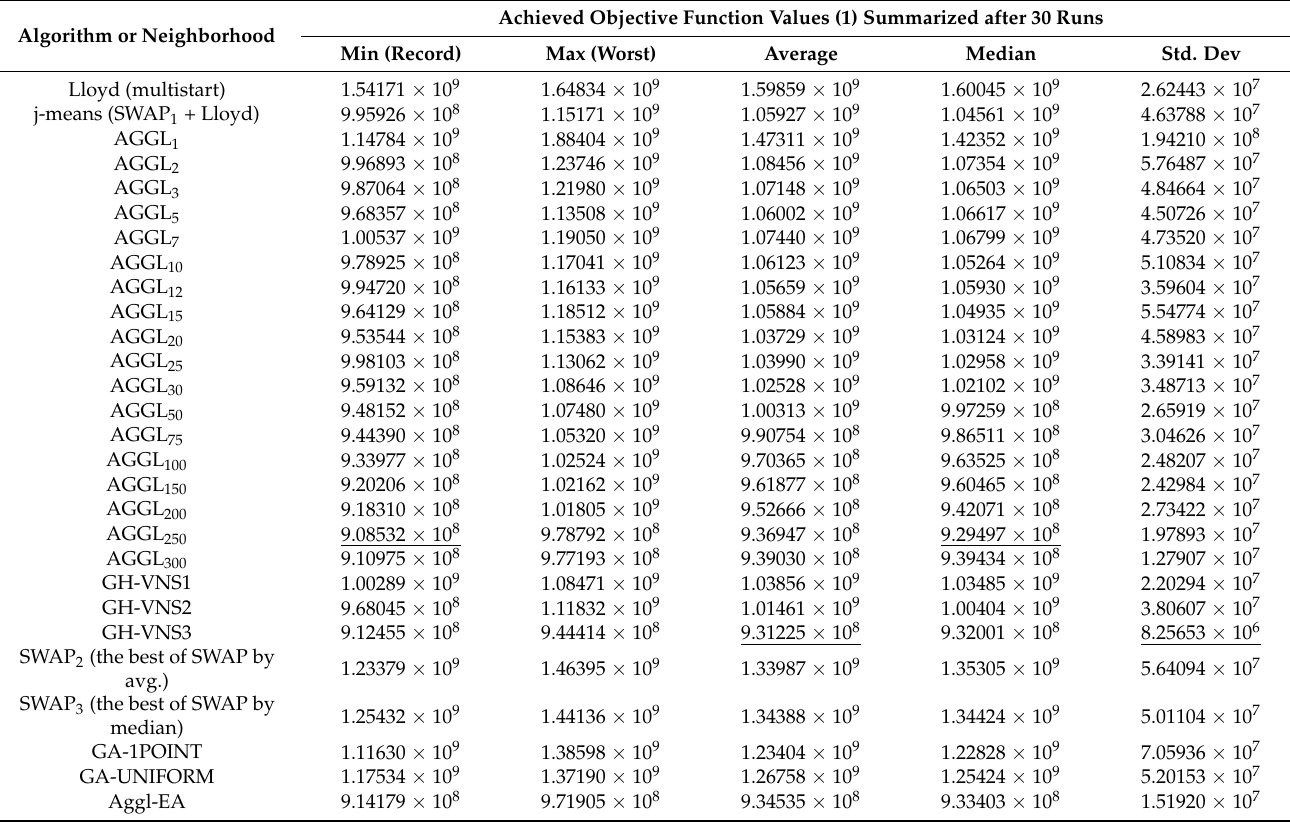
Table A3. Comparative results for BIRCH3 dataset. 10 5 data vectors in R 2 , p = 300 centers, time limitation 10